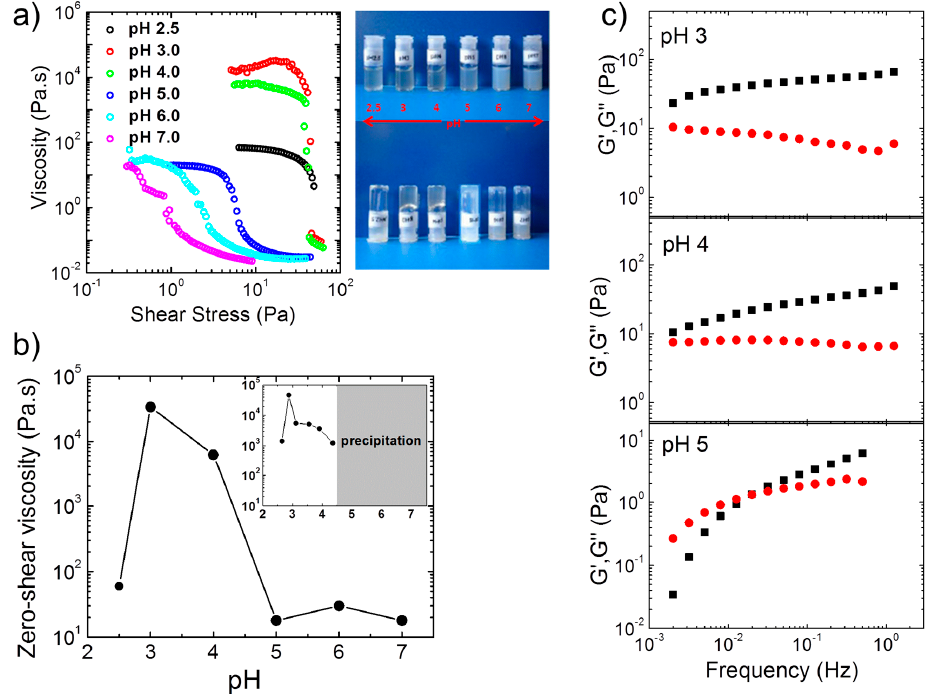
Figure 2. pH-dependent rheological properties of salt-free aqueous solutions of A(QP)A 2 . ( a ) Left : Apparent viscosity as a function of shear stress for A(QP)A 2 at c = 4 wt % and various pH conditions; right : photos showing free-standing gels at pH 3 and 4, whereas solution behavior is observed at other pH values. ( b ) pH dependence of zero-shear viscosity, η 0 , at c = 4 wt % and its precursor APA 2 at c = 1.2 wt % ( inset ). ( c ) Dynamic moduli, G ′ (black symbols) and G ″ (red symbols) versus frequency at different pH values of A(QP)A 2 at c = 4 wt % at the pH values given in the graphs. Adapted with